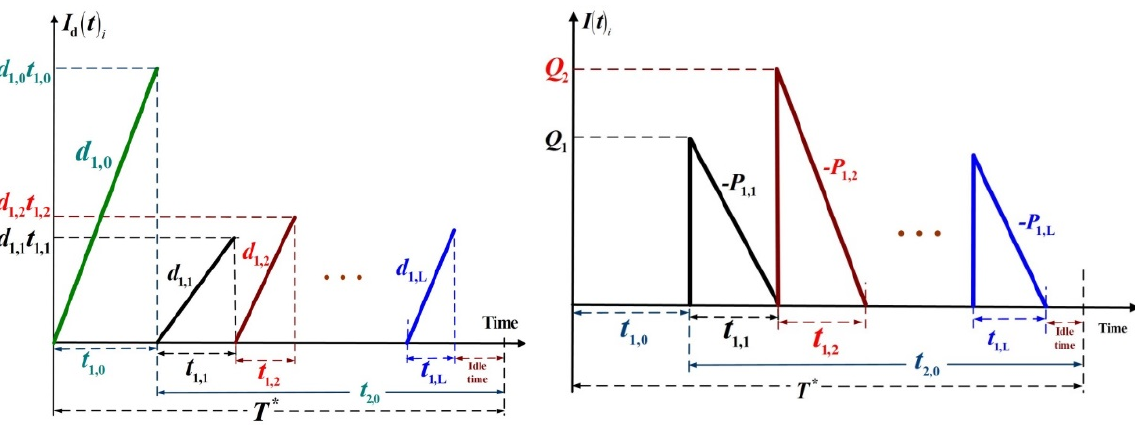
Fig. 2. The defective stocks’ status Fig. 3. Common part’s status as required from fabricating end products in stage